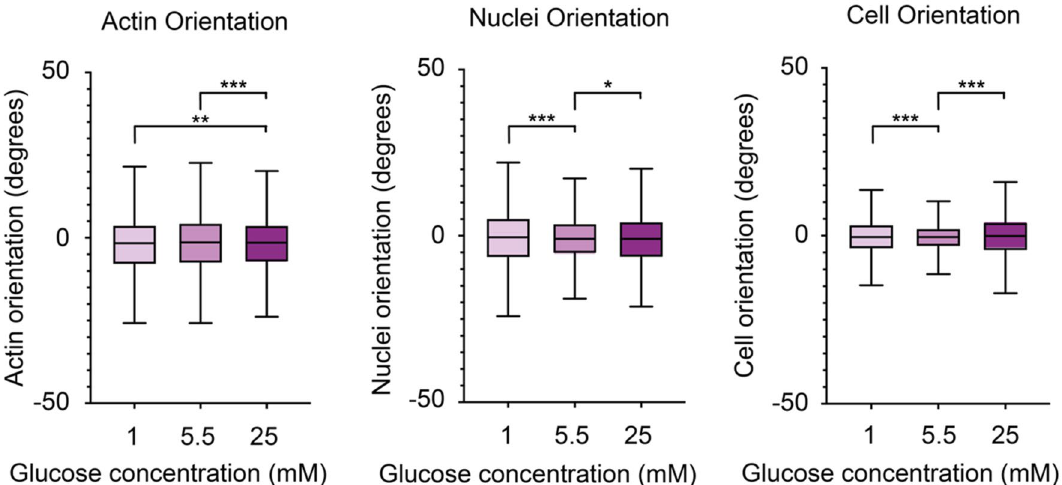
Figure 5. Brain microvascular endothelial cell orientation on 10 µm lines is affected by cell media glucose levels. Box plots of actin orientation, nuclei orientation and cell orientation for the different glucose conditions low (1 mM), normal (5.5 mM), and high (25 mM). For the statistical analysis 750 nuclei and cells and 7500 actin fibres were used for each condition. The statistics included in figure 5 are summarized in Supplementary Tables S6, S7, S8, and *denotes p ≤ 0.05, **denotes p ≤ 0.01, and ***denotes p ≤ 0.001.